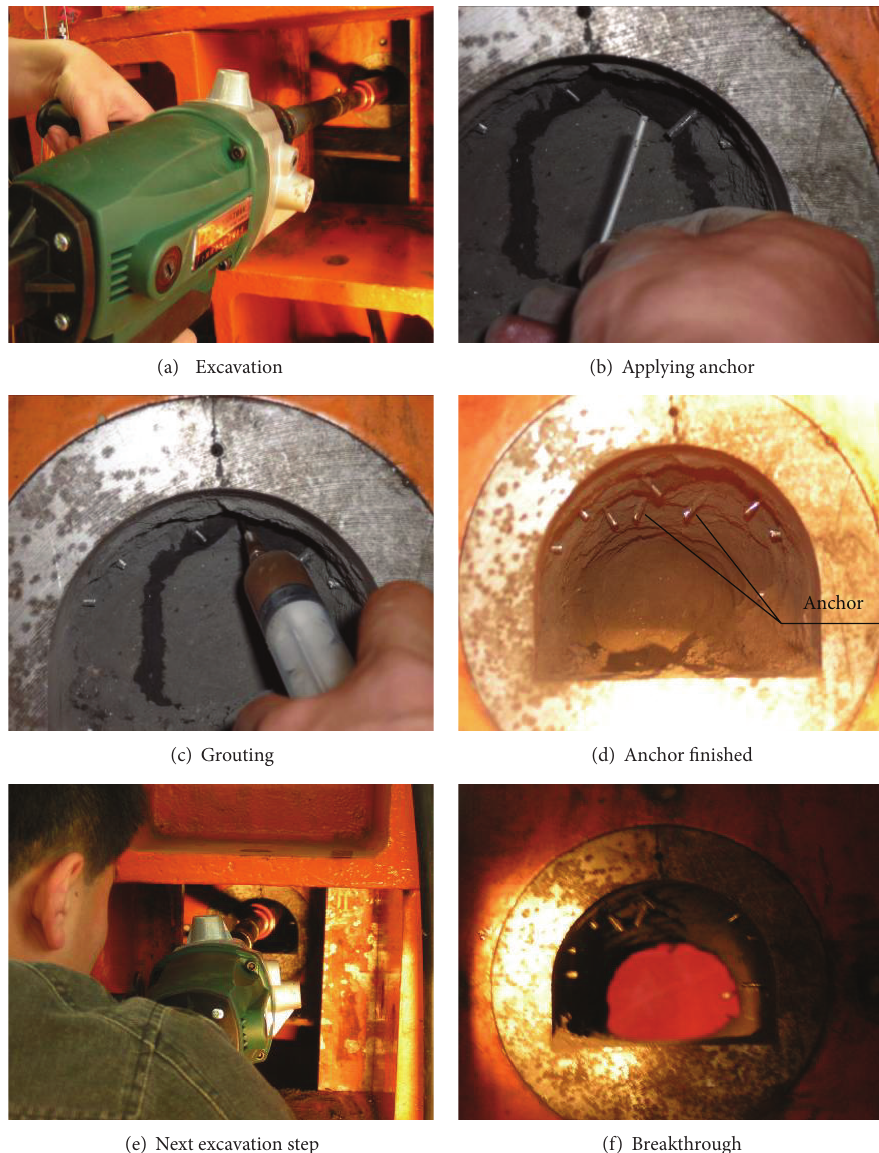
Figure 14: Excavation procedure of model